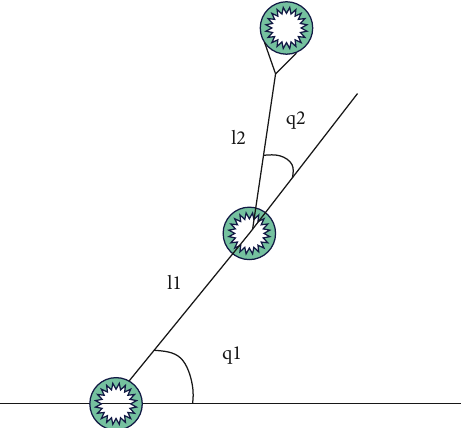
Figure 1: Schematic diagram of a double-joint dance simulation